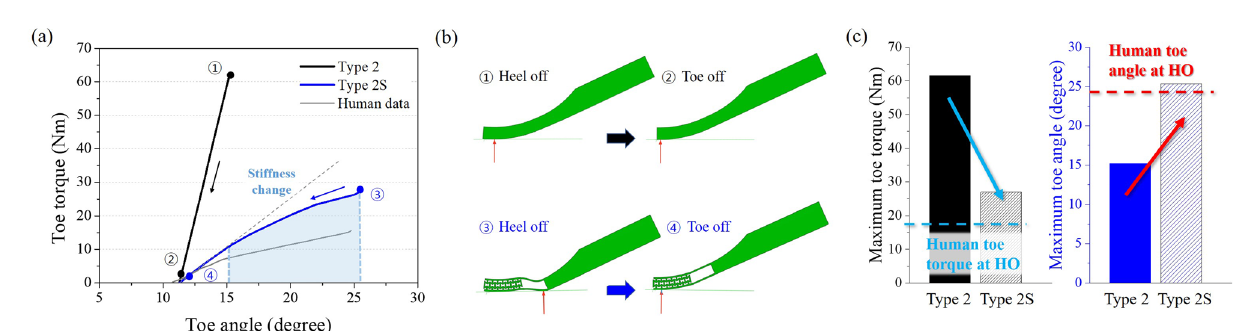
Figure 6. Simulation result of Type 2 and Type 2S models and reference human data 18 from heel off to toe off. ( a ) Toe torque and angle graph. ( b ) Normal contact force position of Type 2 and 2S foot. ( c ) Maximum toe torque and